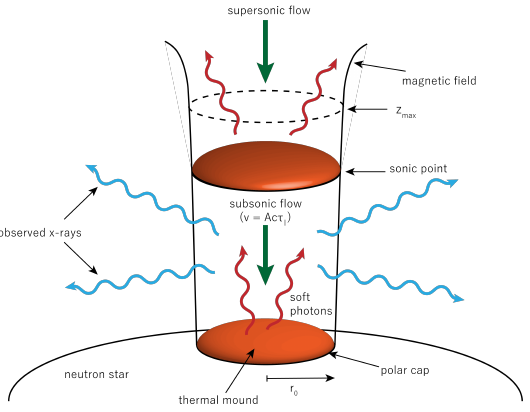
Figure 2. Schematic of the accretion flow near the surface of Her X-1; adapted from